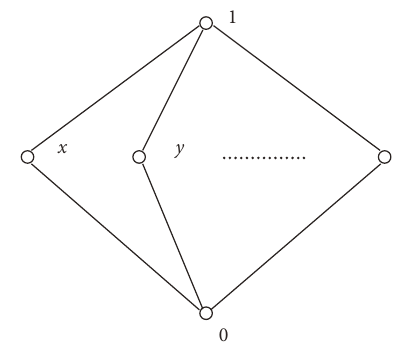
Figure 4: Bounded poset M